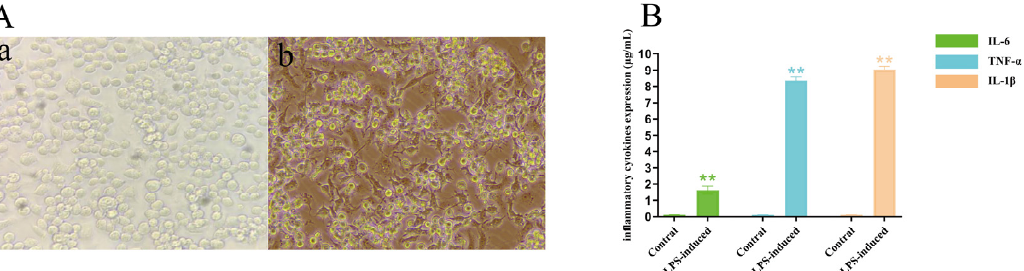
Figure 5. LPS-induced RAW264.7 cell inflammation model. Normally grown cells (a) and cell morphology after LPS treatment (b) (200 × ) ( A ); Expression of proinflammatory factors in RAW264.7 cells were induced by LPS ( B ), ** p < 0.01.